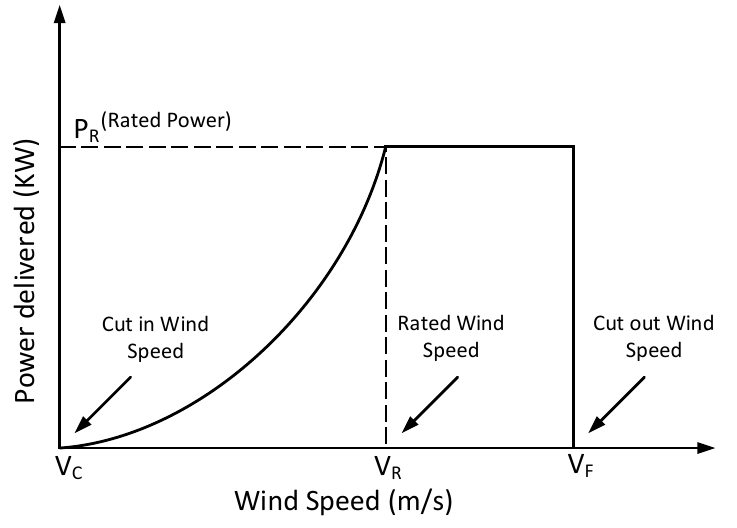
Figure 1. Wind speed power